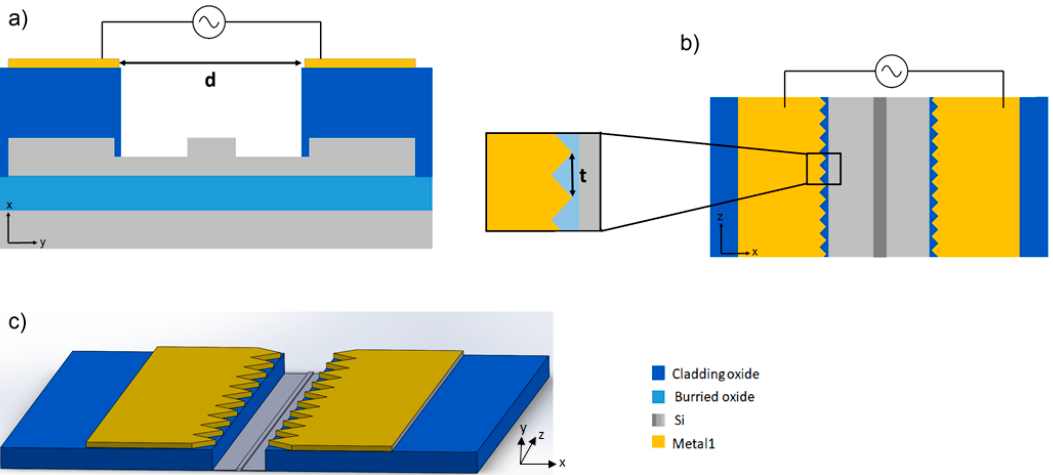
Figure 5. ( a ) Cross-section of the sensing region with the coplanar electrode pair geometry. ( b ) Top view of the coplanar electrode pair geometry. ( c ) 3D view of the sensing region.